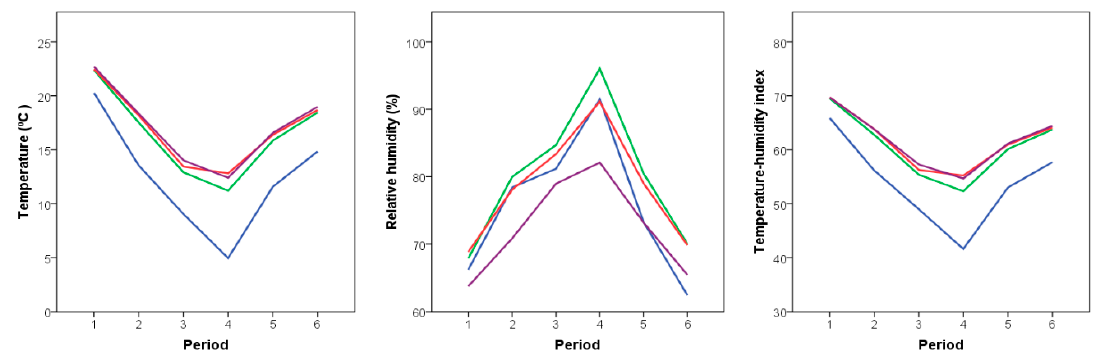
Figure 2. Temporal evolution of the external environmental conditions (in blue) and of the internal environmental conditions for the three management systems (slat + heating plate in green, slat + IR lamp in red and straw bedding + IR lamp in purple). RH: relative humidity; THI: temperature-humidity index.